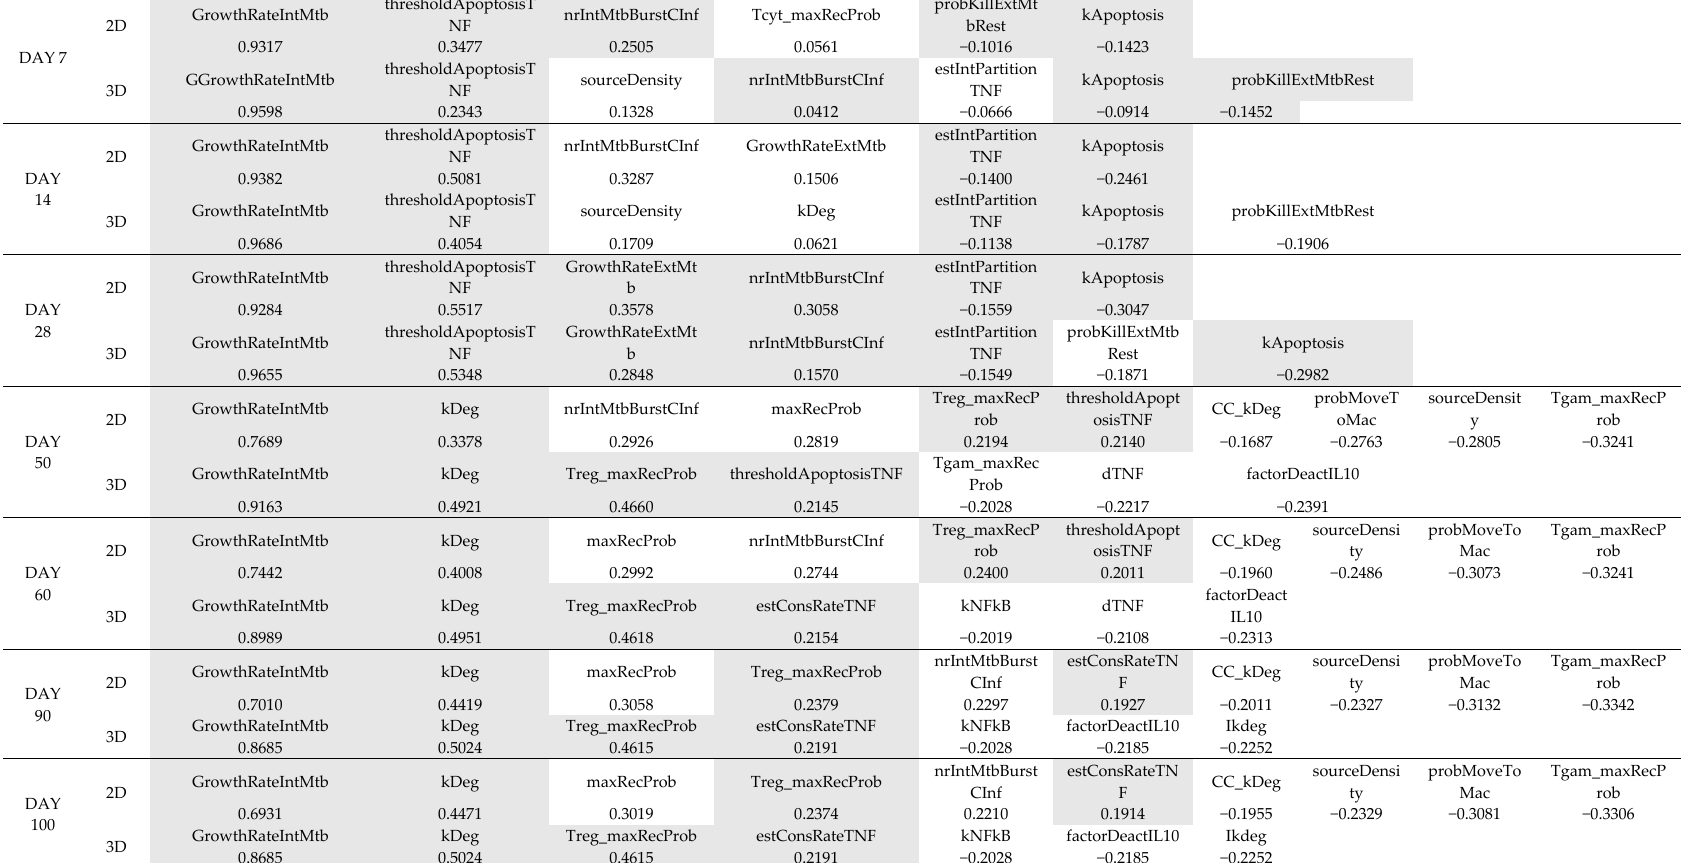
Table 2. PRCC results for both 2D and 3D resolutions. We show the most important and significant ( p < 1 × 10 − 3 ) PRCC values at days 7, 14, 28, 50, 60, 90 and 100 post infection. Although any PRCC between − 0.15 and 0.15 can be considered not important, we show some of them for comparison purposes ( grey cells highlight the 2D–3D overlap).